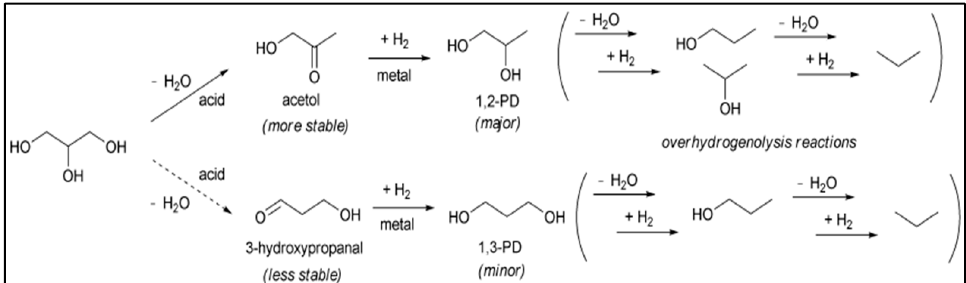
Figure 5. General dehydration–hydrogenolysis mechanism for glycerol.